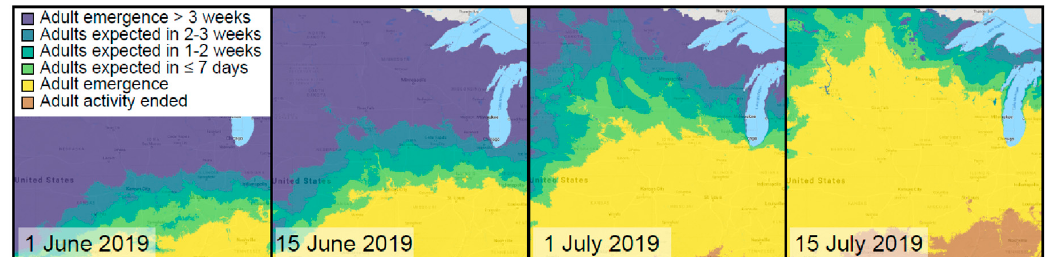
Figure 3. Phenological forecasts. The National Phenology Network’s Pheno Forecast tool (www.usanpn.org / data / forecasts) shows predicted emergence dates for common agricultural pests. This figure shows single-day forecasts for the apple maggot fly, Rhagoletis pomonella (Walsh) in the upper Great Lakes region of the United States of America. Source: USA National Phenology Network,